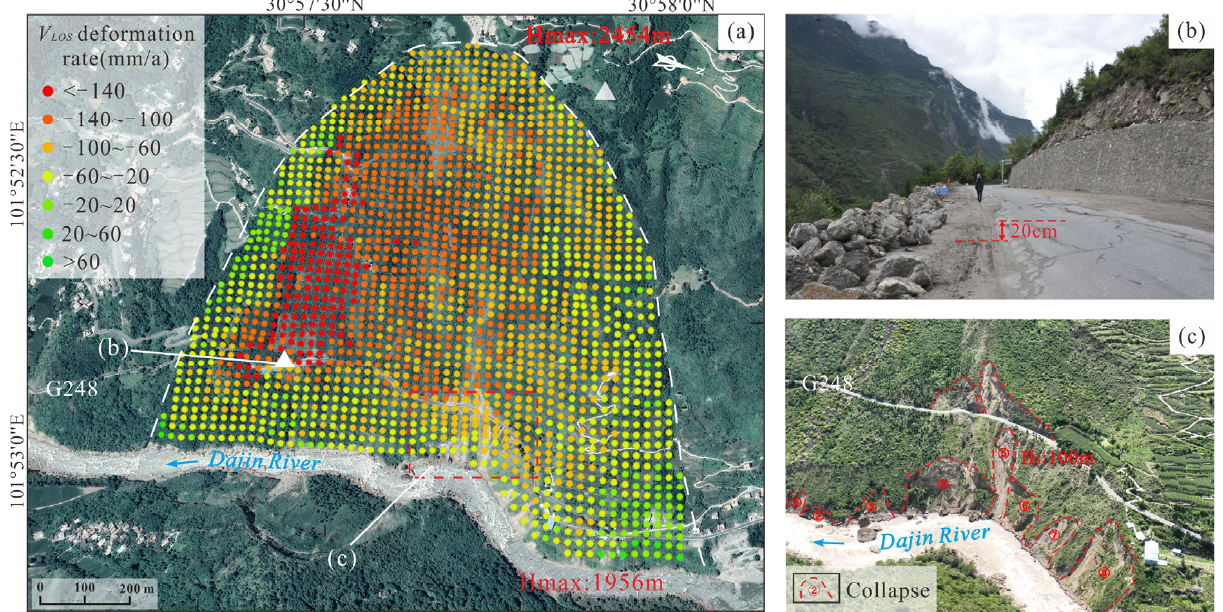
Figure 9. Deformation of the Niela landslide (H04); ( a ) InSAR deformation map of the Niela landslide; ( b ) road subsidence phenomenon (mirror to SE); ( c ) nine collapses at the front edge (based on UAV).